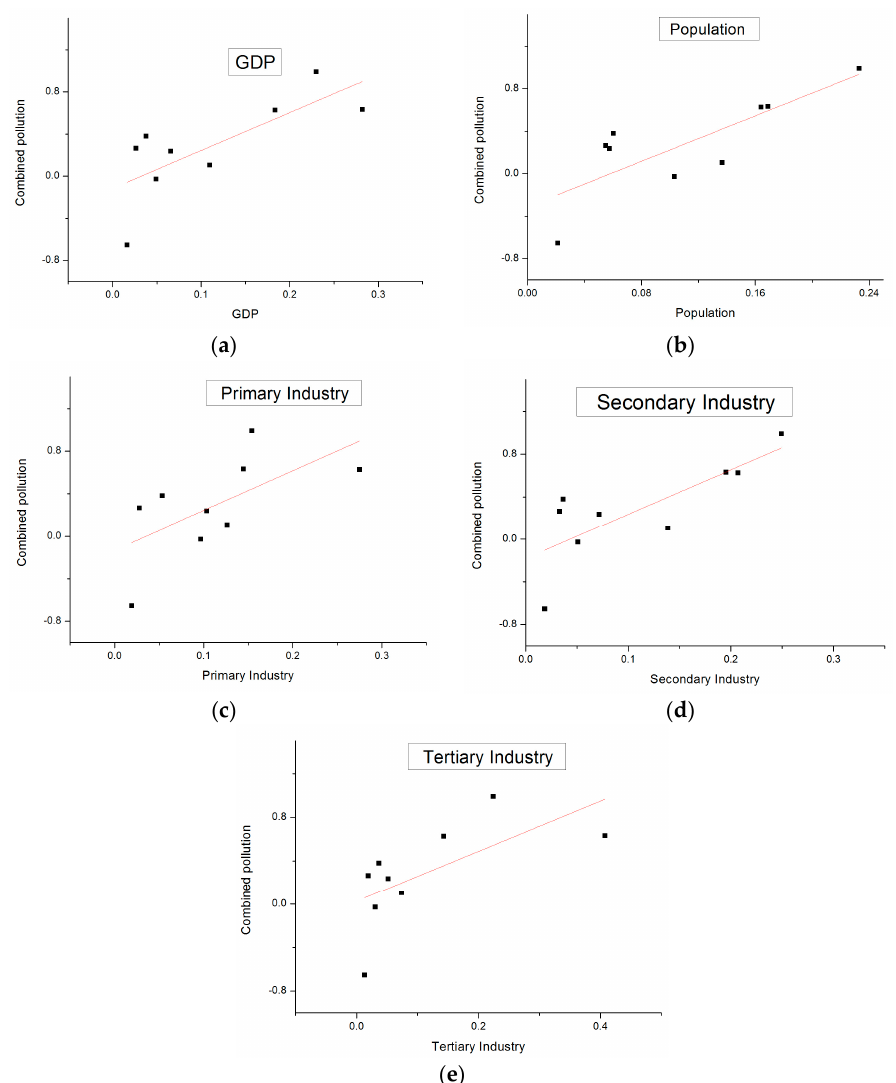
Figure 4. ( a ) Correlation between GDP and degree of combined pollution of eutrophication in water bodies and potential risk of heavy metals in sediments in the Haihe River Basin; ( b ) Correlation between population and degree of combined pollution of eutrophication in water bodies and potential risk of heavy metals in sediments in the Haihe River Basin; ( c ) Correlation primary industry and degree of